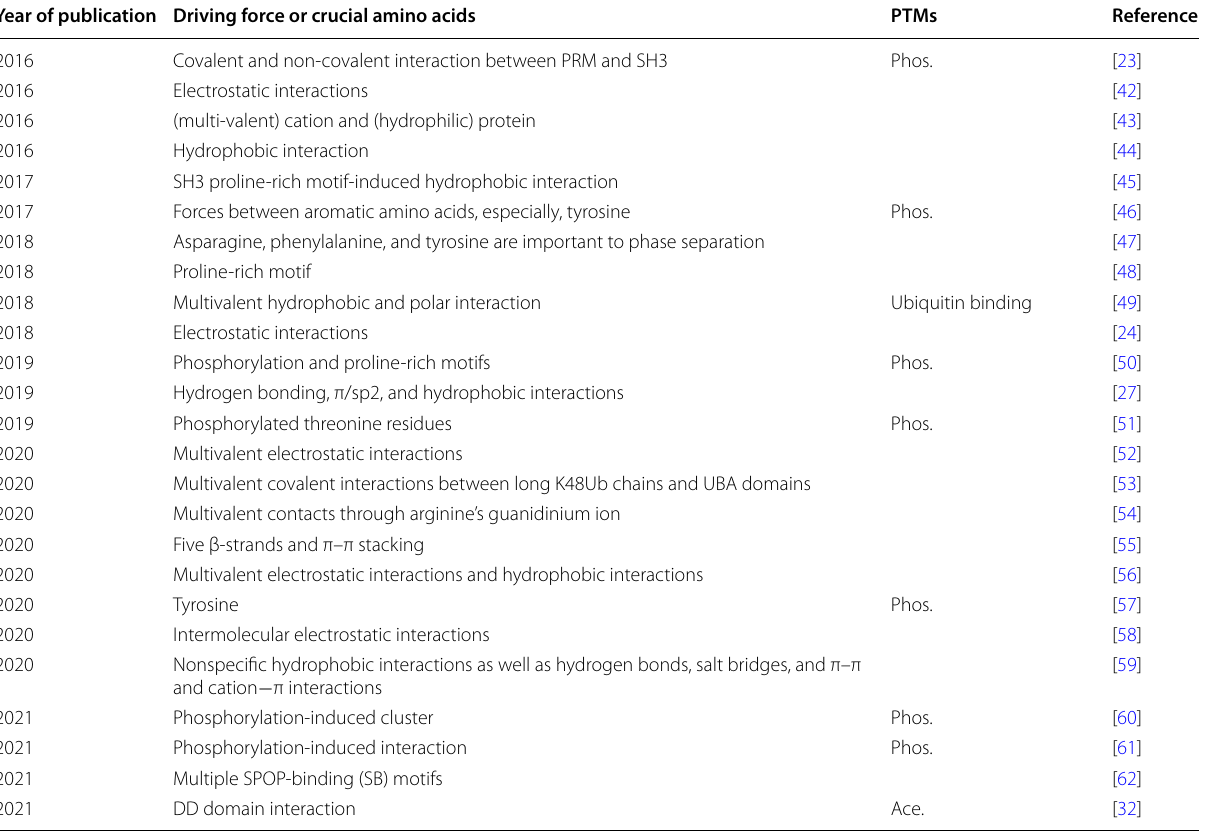
Table 1 Multivalency in phase separation Year of publication Driving force or crucial amino